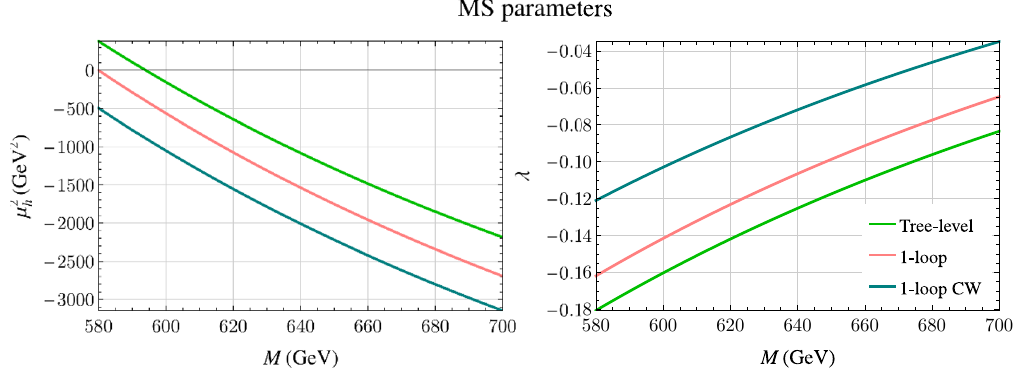
Figure 11 . Higgs MS-parameters as a function of the cutoff scale M in different